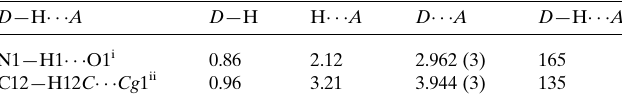
Table 1 Hydrogen-bond geometry (A˚ , (cid:4) ). Cg 1 is the centroid of the N1/C4–C7 ring.